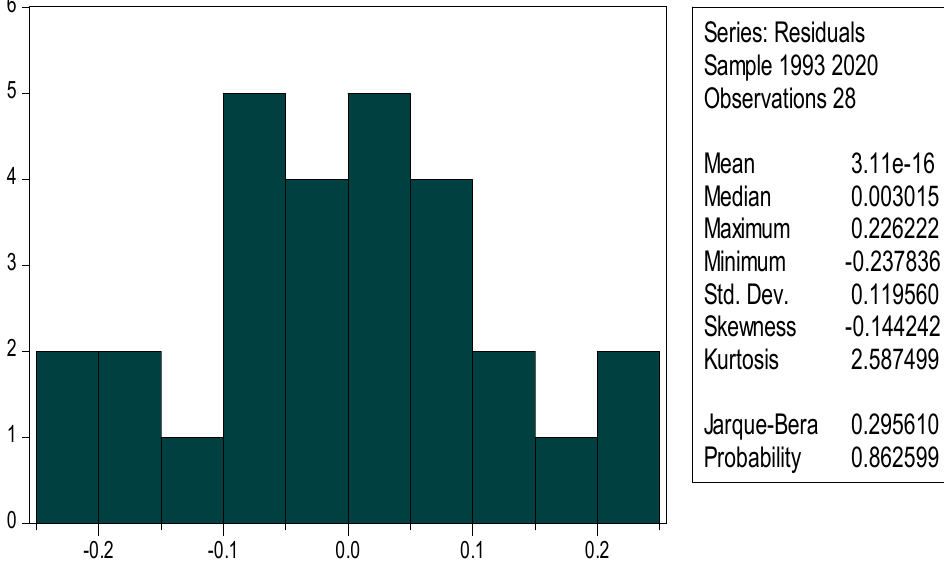
Figure 2. Normality